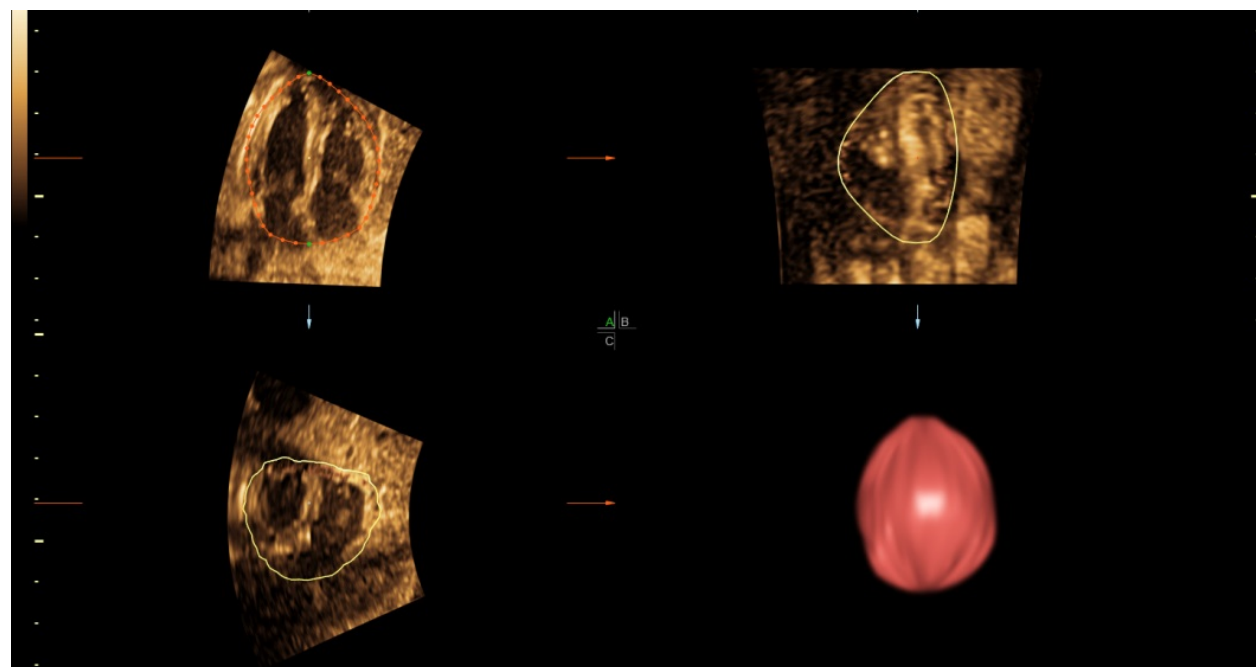
Figure 1. An example of cardiac volume measurement at 20 weeks of gestation, using VOCAL techniques, with rendering to show the volume of 10.52 mL (A/B/C is the name of each panel in multiplanar view).